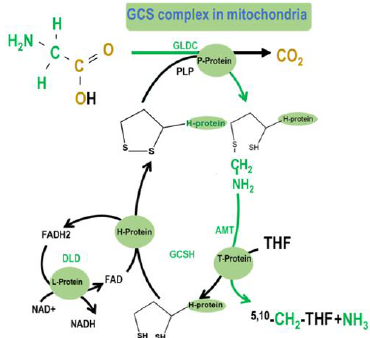
Figure 1. The glycine cleavage system (GCS) is a multienzyme complex that mediates the breakdown of glycine in mitochondria. Glycine decarboxylase ( GLDC ; glycine dehydrogenase) catalyzes the first step of glycine cleavage, releasing CO 2 , with an accessory H protein GCSH, to which the amino methyl moiety is transferred [10]. The subsequent reaction is catalyzed by amino methyltransferase (AMT) that transfers the second 1C unit to tetrahydrofolate (THF), generating 5,10-CH 2 -THF. The further steps of mitochondrial folate 1C metabolism ultimately supply 1C units as formate to the cytoplasm for nucleotide biosynthesis and methylation reactions